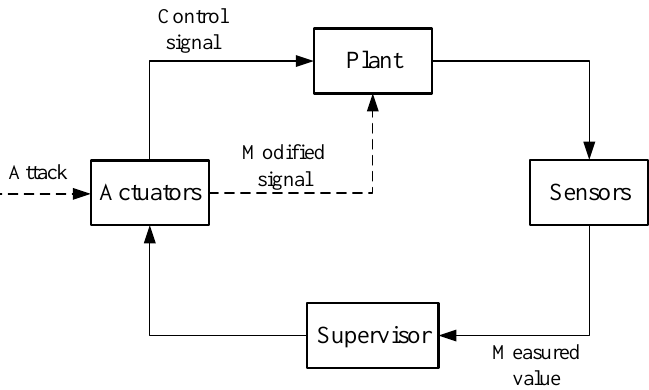
Figure 1. The closed-loop control system